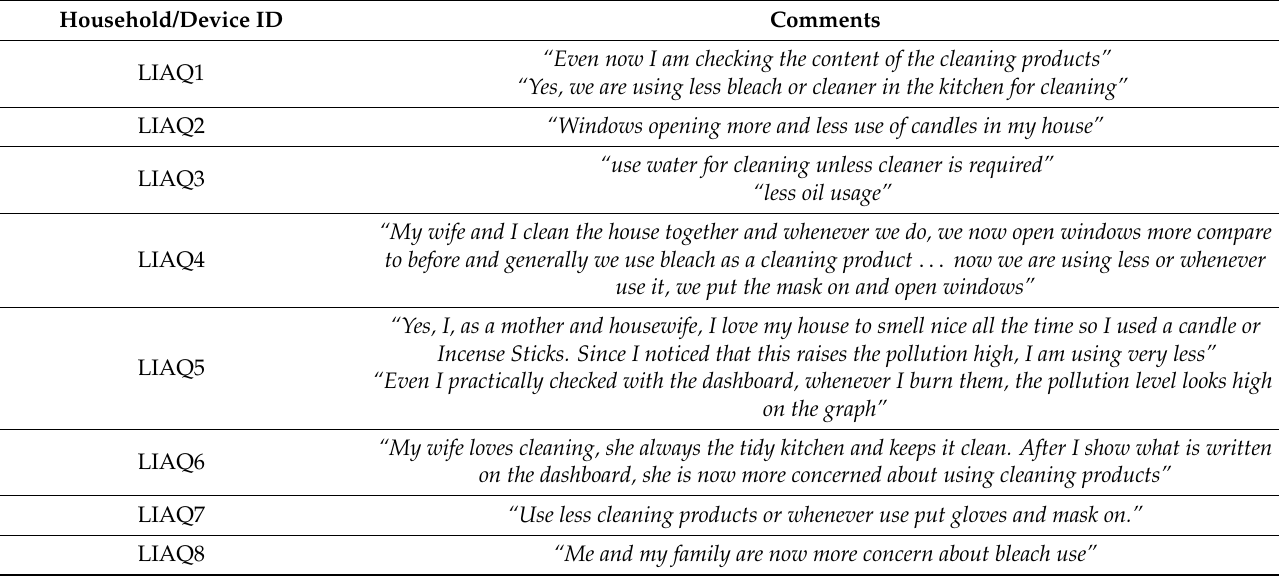
Table 7. Answers to interview questions: “Did you change any of your regular day-to-day activities after seeing data on your IAQ